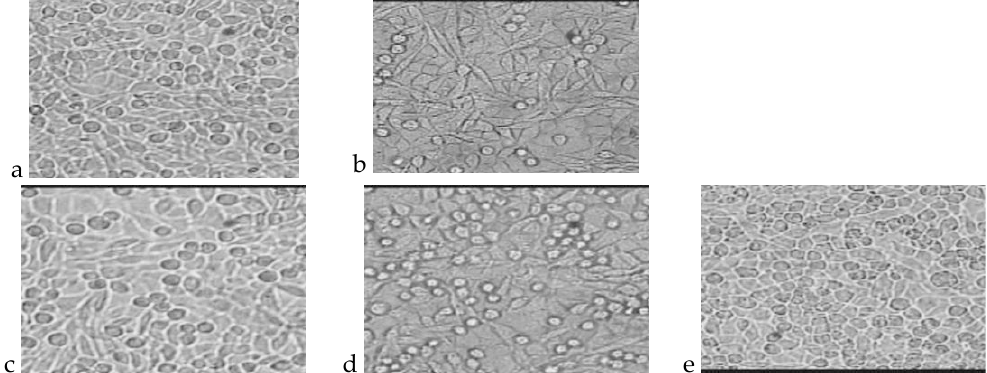
Figure 4. L929 cell cultures obtained during the cytotoxicity test of the indirect method (polar extract) after 72 h of incubation. ( a ) Cells incubated with PLGA extract; ( b ) Cells incubated with PLGA + IGF1 extract; ( c ) Cells incubated with PLGA/PHB extract; ( d ) Cells incubated with PLGA/PHB + IGF1 extract; ( e ) L-929 culture without contact with extract from tested materials. Table 7. Number of cells and level of cytotoxicity after 72 h of incubation—indirect method (nonpolar extract).